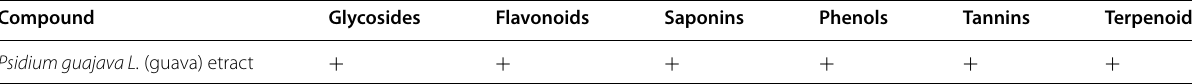
Table 1 Phytochemical analysis of guava leaf